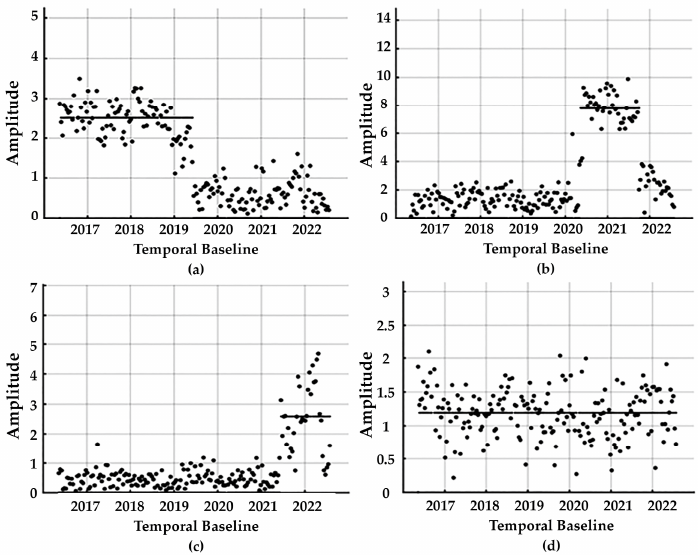
Figure 12. Illustration of the different patterns present in the time-series named in Table 2 as ( a ) demolition, ( b ) ephemeral, ( c ) new building, and ( d ) persistent scatterer.